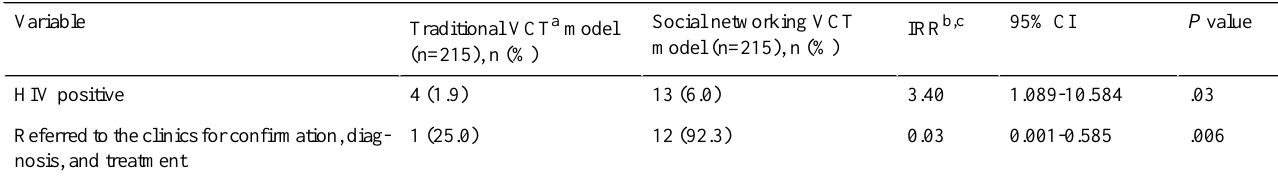
Table 4. The comparison of the HIV case finding and clinic referrals between the 2 voluntary counseling and testing